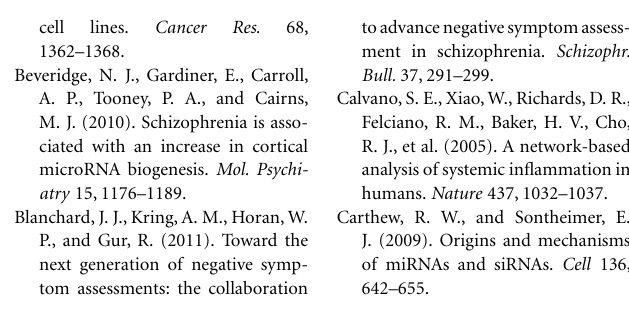
Table S1 | miR-137 putative target list, chromosomal locations and disease associations . Figure S1 | miR-137 targets in Sertoli cell-signaling canonical pathway . Figure shows the Sertoli cell-signaling pathway from IPA with the symbols for all miR-137 putative and verified targets shown in orange. Figure S2 | miR-137 targets in agrin interaction at the neuromuscular junction canonical pathway . Figure shows the agrin interaction at the neuromuscular junction pathway from IPA with the symbols for all miR-137 putative and verified targets shown in orange. Figure S3 | miR-137 targets in synaptic long-term potentiation (LTP) canonical pathway . Figure shows the synaptic LTP pathway from IPA with the symbols for miR-137 putative and verified targets shown in orange. Figure S4 | miR-137 targets in ephrin receptor signaling canonical pathway . Figure shows the ephrin receptor signaling pathway from IPA with the symbols for all miR-137 putative and verified targets shown in orange. Figure S5 | miR-137 targets in axonal guidance canonical pathway . Figure shows the axonal guidance pathway from IPA with the symbols for all miR-137 putative and verified targets shown in